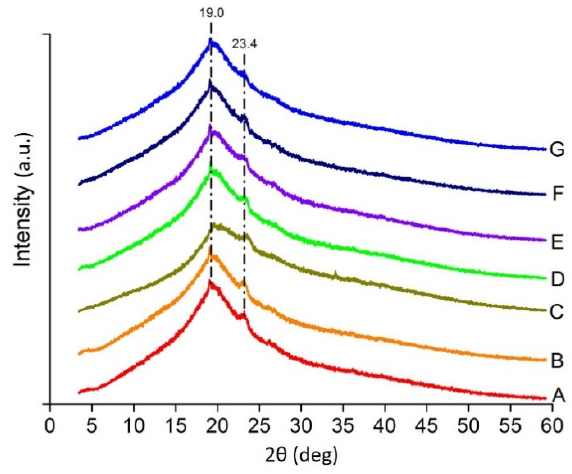
Figure 4. X-ray diffraction patterns of heat pressed films (A–G). Table 3. Mechanical properties of the heat pressed films (E = Young’s Modulus, σ = Tensile strength and ε = Elongation at break).